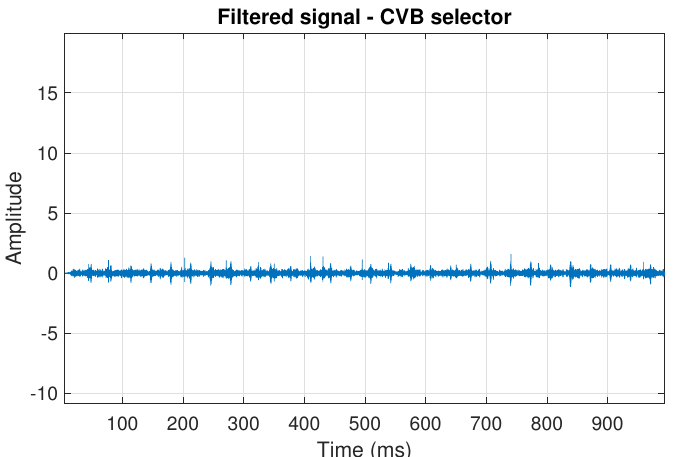
Figure 7. Filtered signal s 1 by CVB selector.